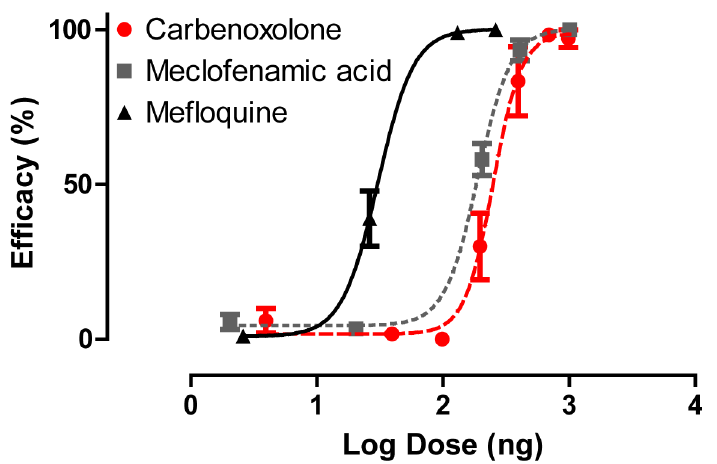
Fig 1. Dose-response curves of gap junction inhibitors injected directly into the hemolymph of adult female A . aegypti mosquitoes (carbenoxolone R 2 = 0.873, meclofenamic acid R 2 = 0.957 and mefloquine R 2 = 0.906). Efficacy (dead and flightless mosquitoes) was assessed 24 h after injection. Taking into consideration the average mass of an adult female mosquito (1.97 mg), the ED 50 for carbenoxolone, meclofenamic acid and mefloquine are 127.3 ng/mg, 96.4 ng/mg and 15.47 ng/mg respectively. Values are means ± SEM. n = 5 – 10 replicates of ten mosquitoes per dose